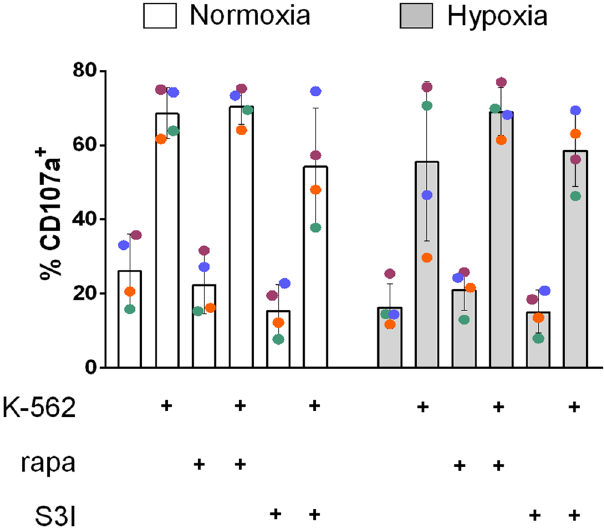
Figure 5. mTORC1 and STAT3 inhibition does not interfere with K-562 cell contact induced NK cell degranulation. NK cells were incubated under normoxia and hypoxia for 16 h and subsequently co-incubated with K-562 cells for 4 h in the presence of IL-15 and under continued normoxia and hypoxia, respectively, with or without rapamycin (rapa) and S3I-201 as indicated. Pooled flow cytometric data for the proportions of CD107a positive cells are shown as mean values ± SD (n = 4). The level of statistical significance was not reached when applying the Wilcoxon signed-rank